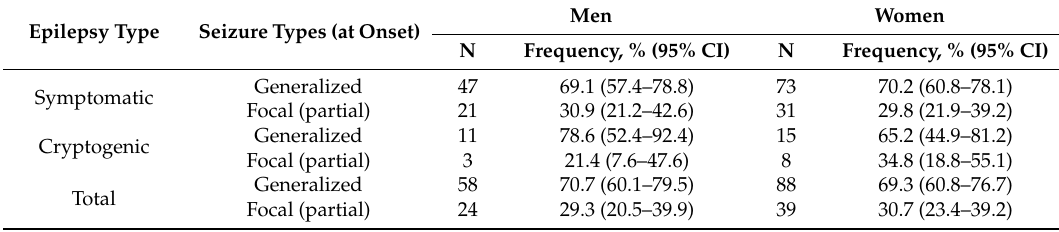
Table 5. The frequency of seizure types at the onset of epilepsy in men and